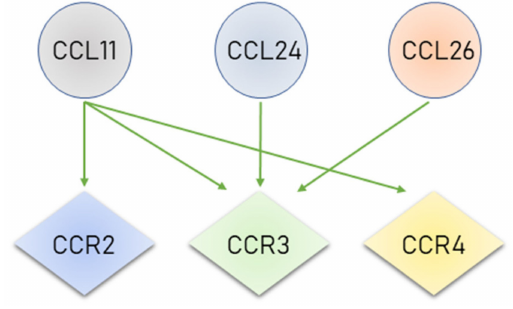
Figure 1. Eotaxins and their